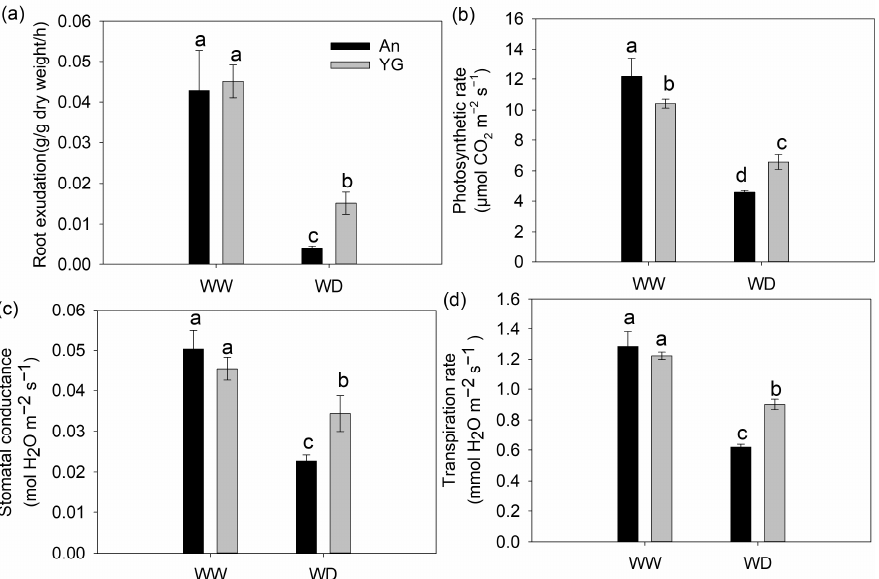
Figure 1. Effect of soil water status on the ( a ) root exudation and leaf photosynthetic parameters, ( b ) net photosynthesis rate, ( c ) stomatal conductance, ( d ) and transpiration rate of the two cultivars at the flowering state. The different letters represent significant differences of WD, WW, An and YG ( p < 0.05).